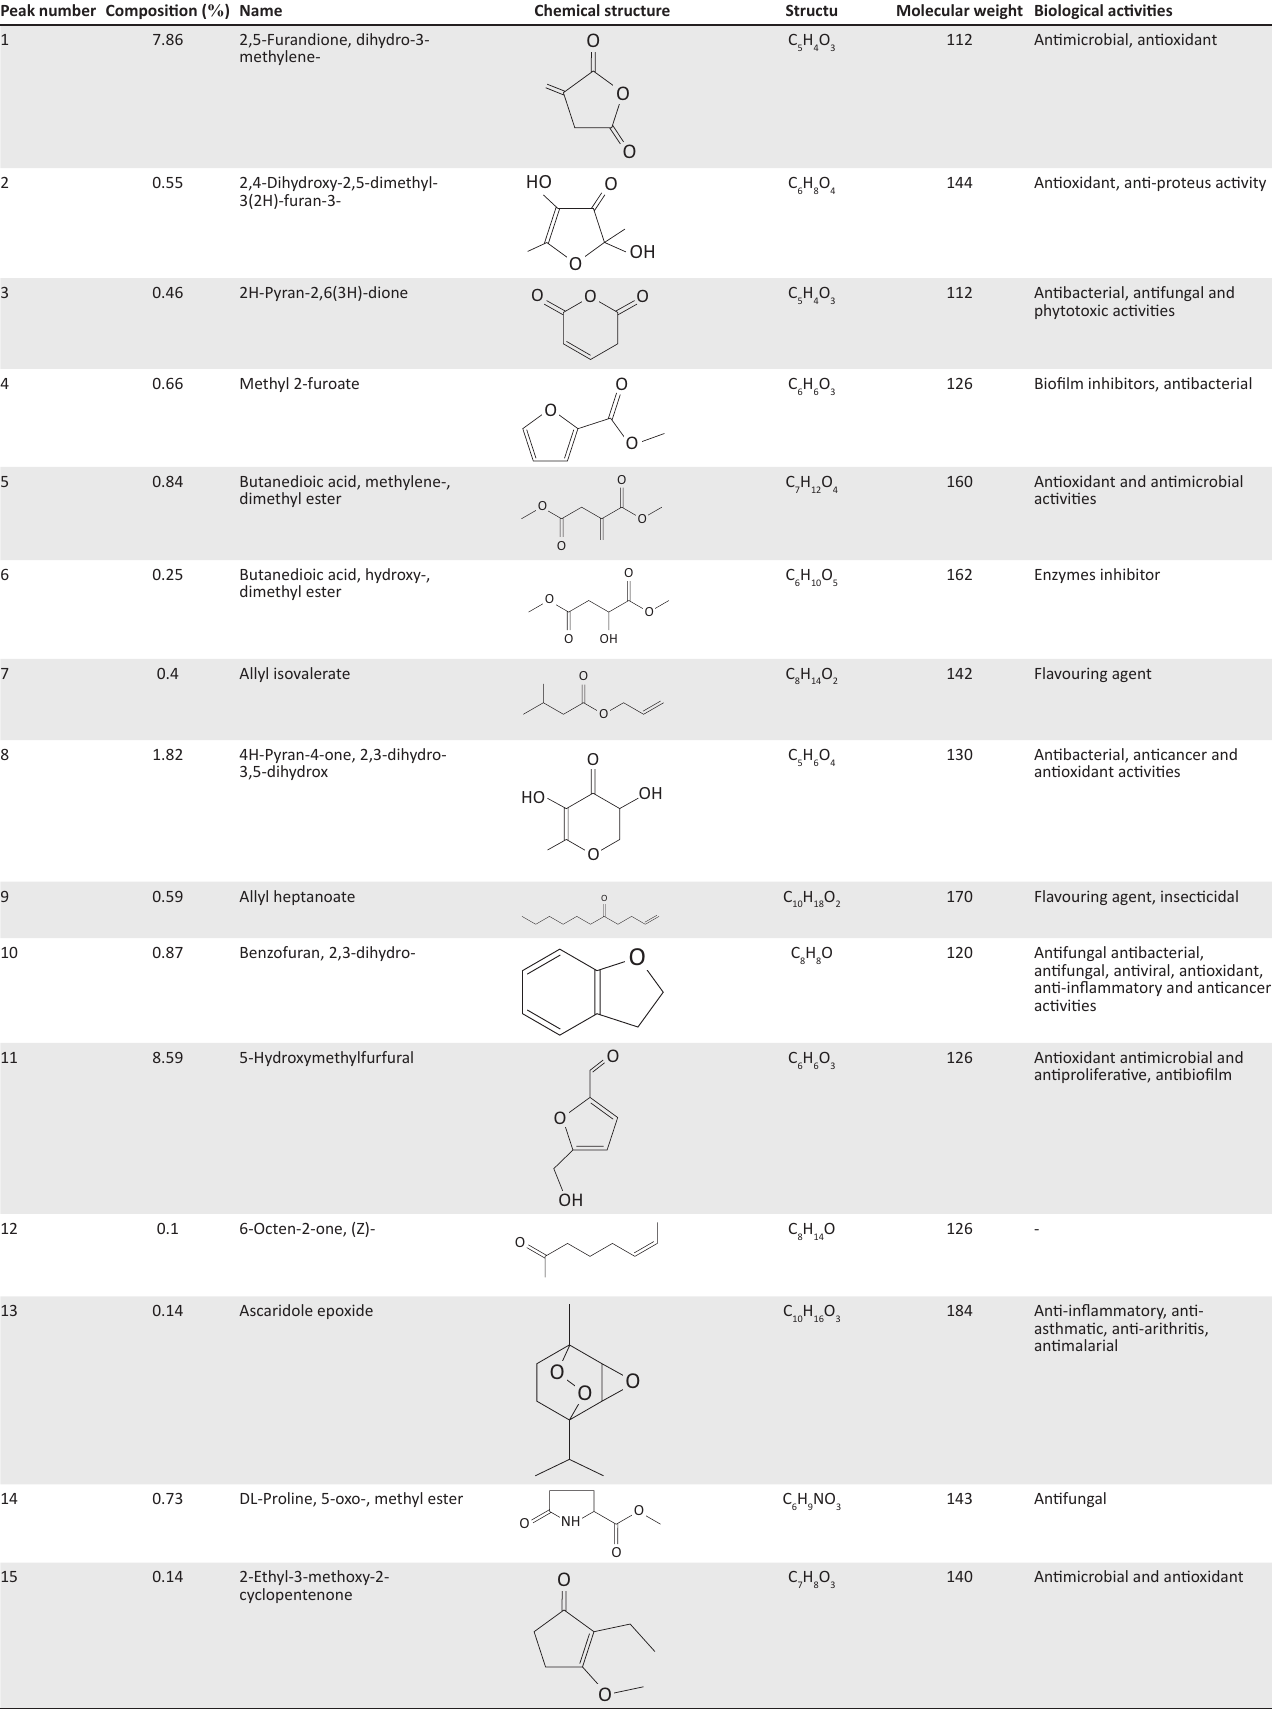
TABLE 1: Chemical compounds in ethylacetate extract of Adansonia digitata identified by gas chromatography–mass spectrometry. Peak number Composition ( % )